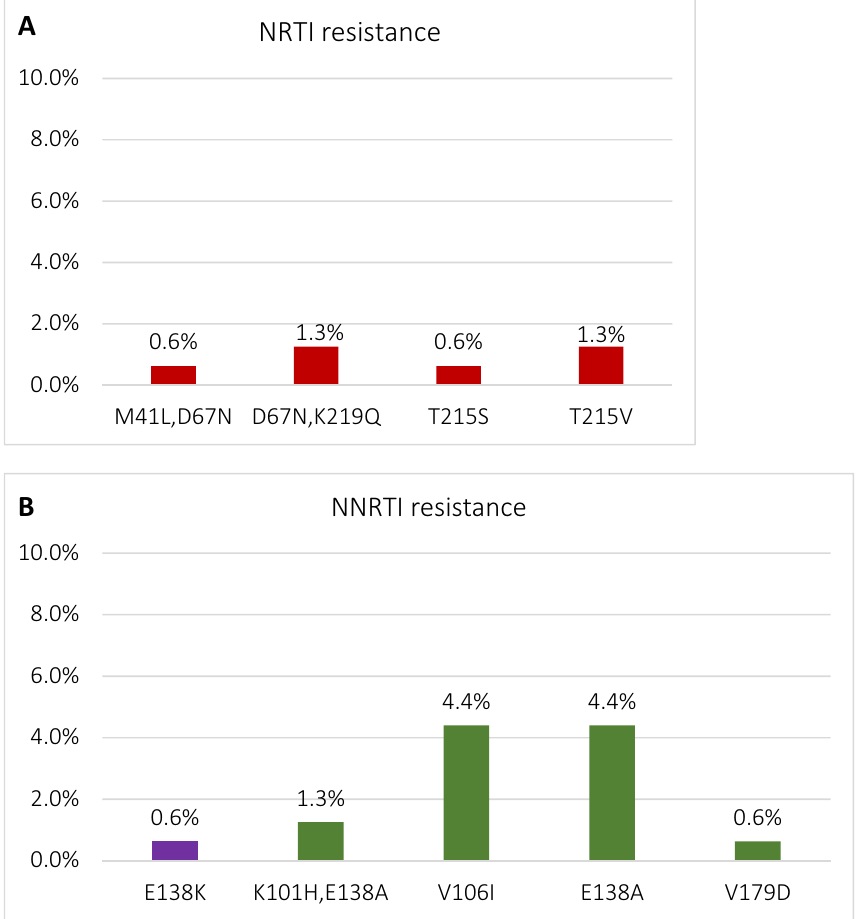
Figure 3. Frequency of major and transmitted drug resistance mutations (red) and variants associated with decreased drug susceptibility (Stanford HIV DB, score ≥ 10, green) for nucl(t)eoside reverse transcriptase ( a ), non-nucleoside reverse transcriptase ( b ), protease ( c ) and integrase ( d ) inhibitors. As non-nucleoside reverse transcriptase E138A mutation is not included in the tDRM list, but is associated with significant reduction of susceptibility to rilpivirine, it was marked in